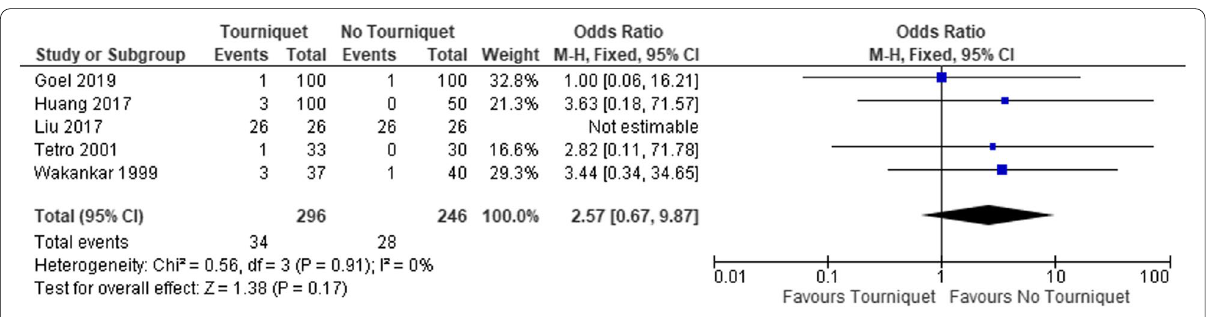
Fig. 8 Comparing the proportion of skin